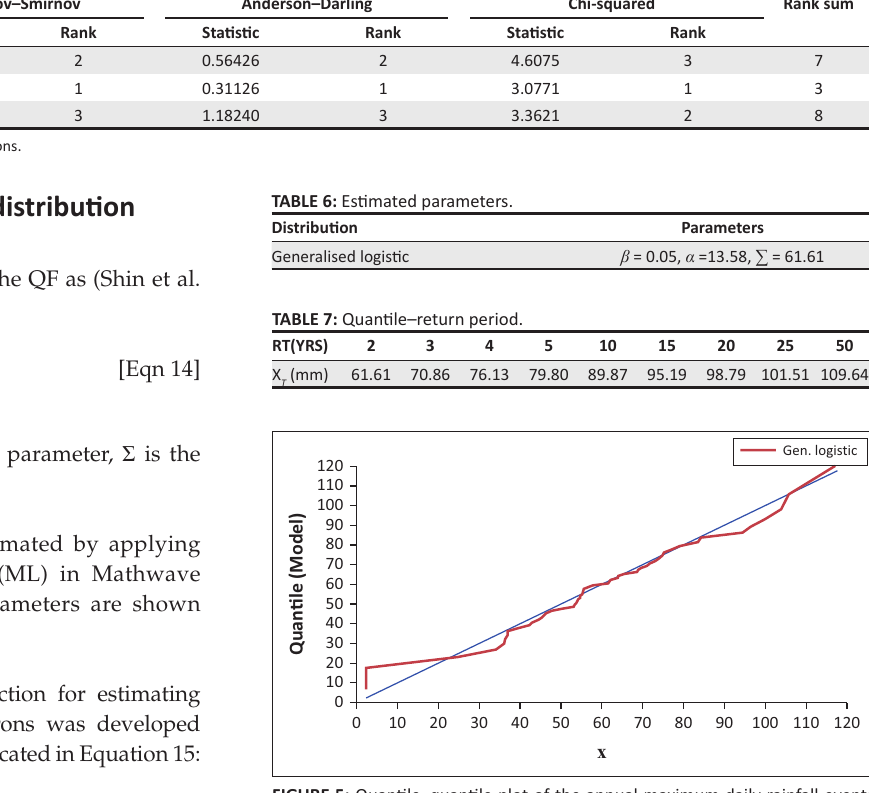
TABLE 5: Best-fit distribution. TCPDF